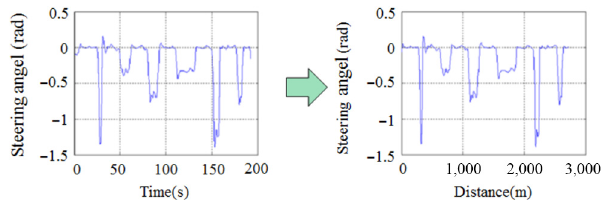
Figure 5 Data before/after